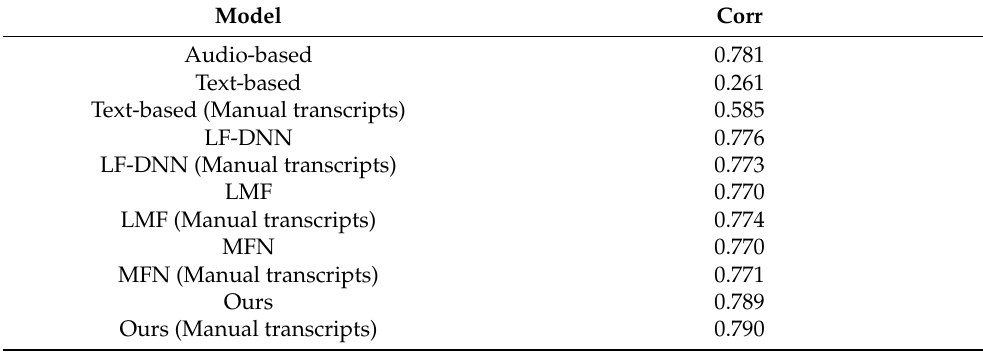
Figure 7. Effect of different text features in PSCPSF on experimental results. Table 11. The performance on Speechocean762.